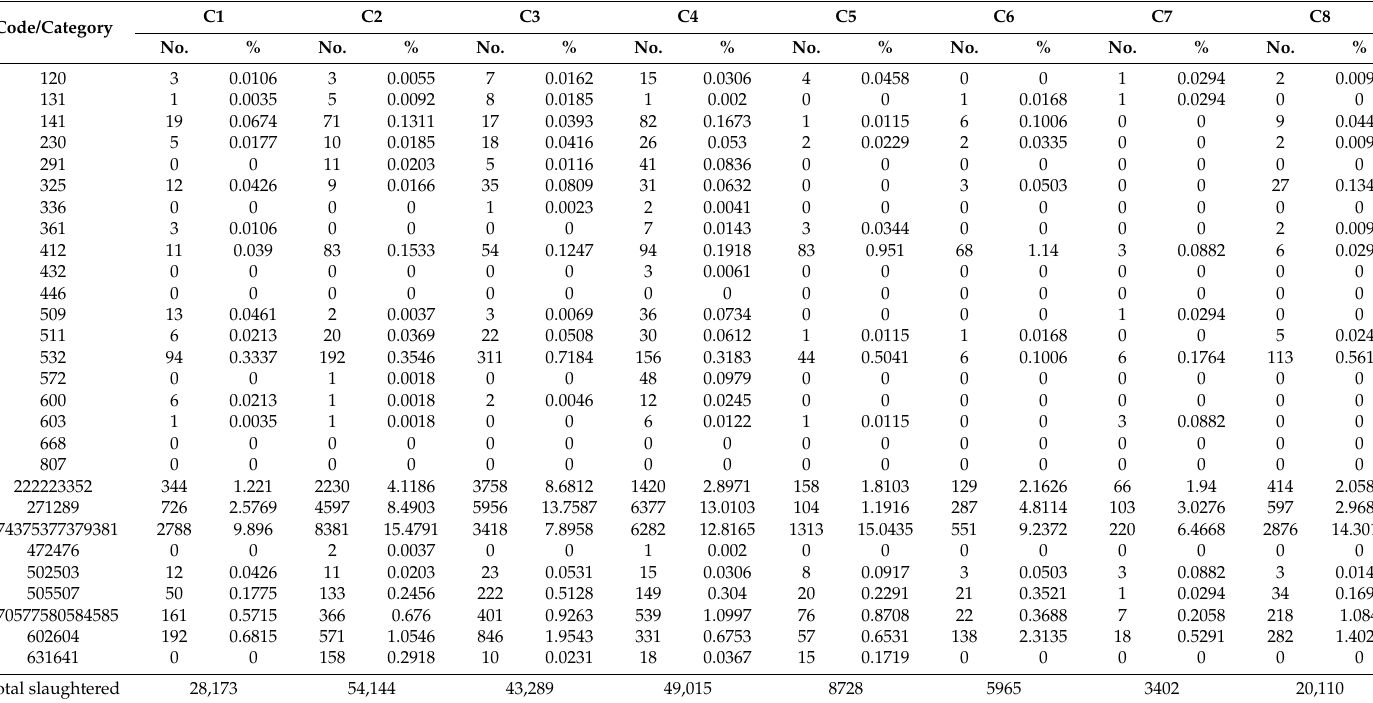
Table 3. Prevalence of selected slaughter recording codes or categories in 212,826 cattle <18 months of age slaughtered at the eight largest cattle slaughterhouses (C1–C8) in